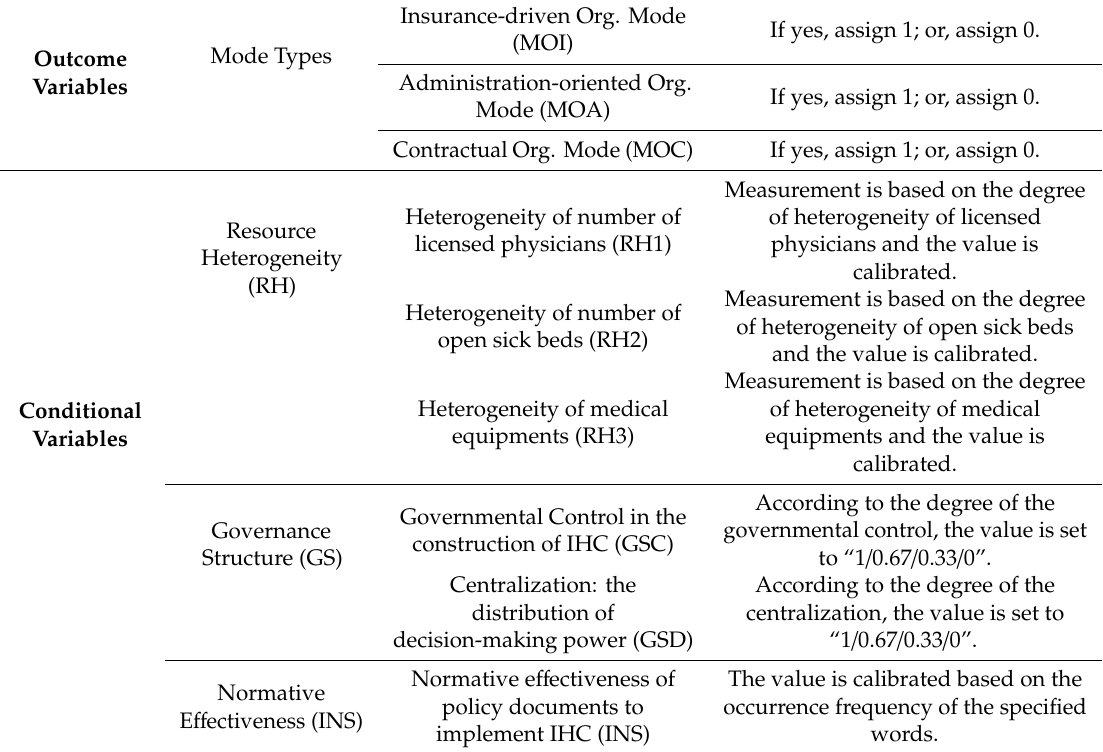
Table 4. Analytical dimensions and measurement of